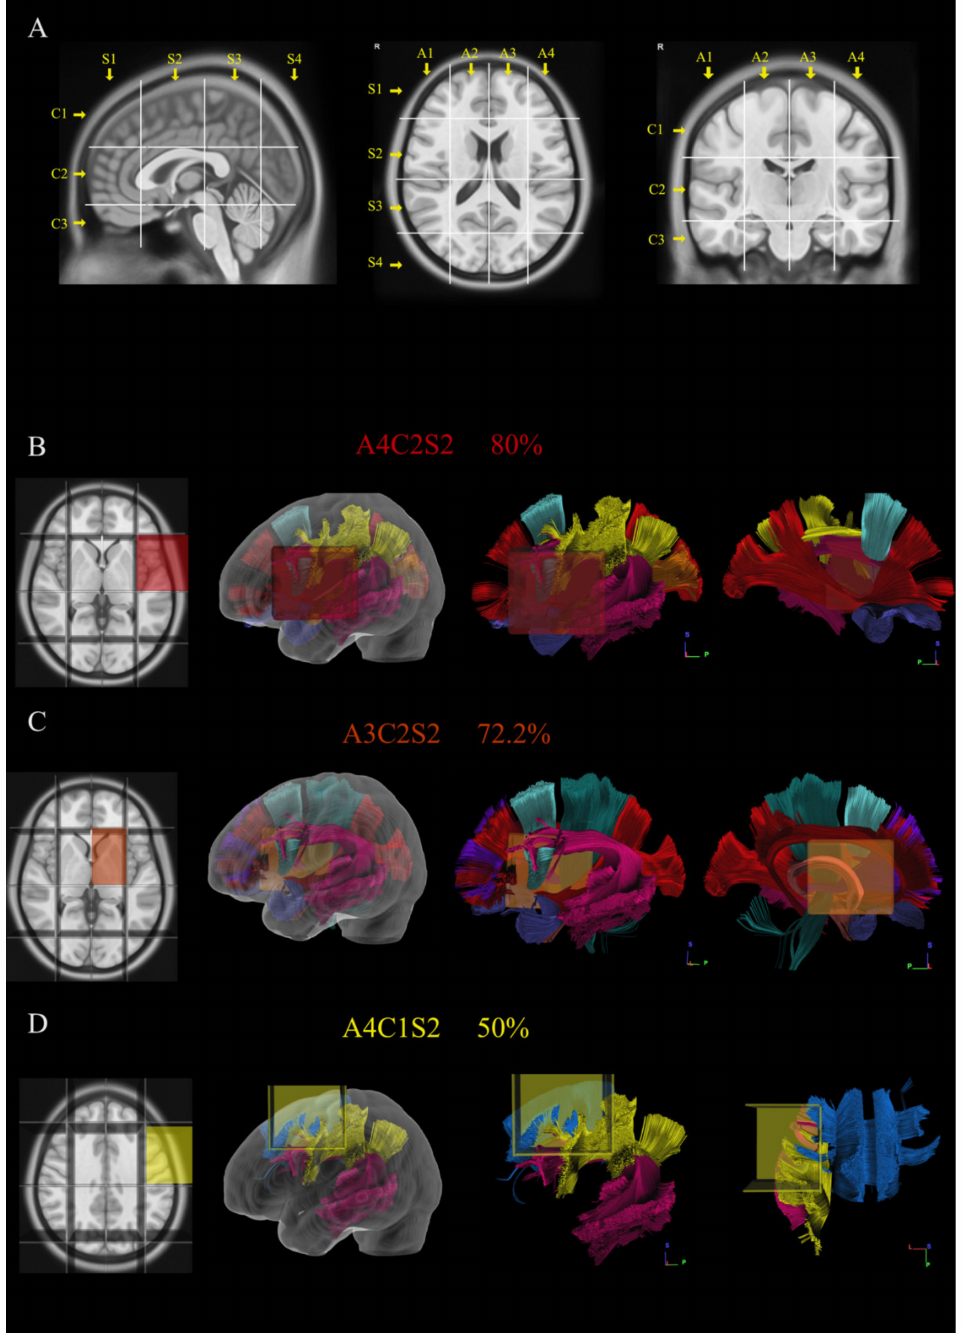
Figure 1. The picture shows in ( A ) the construction and use of Brain-Grid system in MNI space. Three sagittal lines cross the anterior insular point (the most anterior landmark of the insular sulcus), the posterior insular point and the temporo-occipital junction (between the posterior portion of the fusiform gyrus and the inferior occipital sulcus more basally on the axial plane). These lines segment the whole brain into four grid voxels labeled with the first coordinate S (from sagittal line). The S1 voxel is the pre-insular/prefrontal portion of both hemispheres. The S2 is enclosed within the